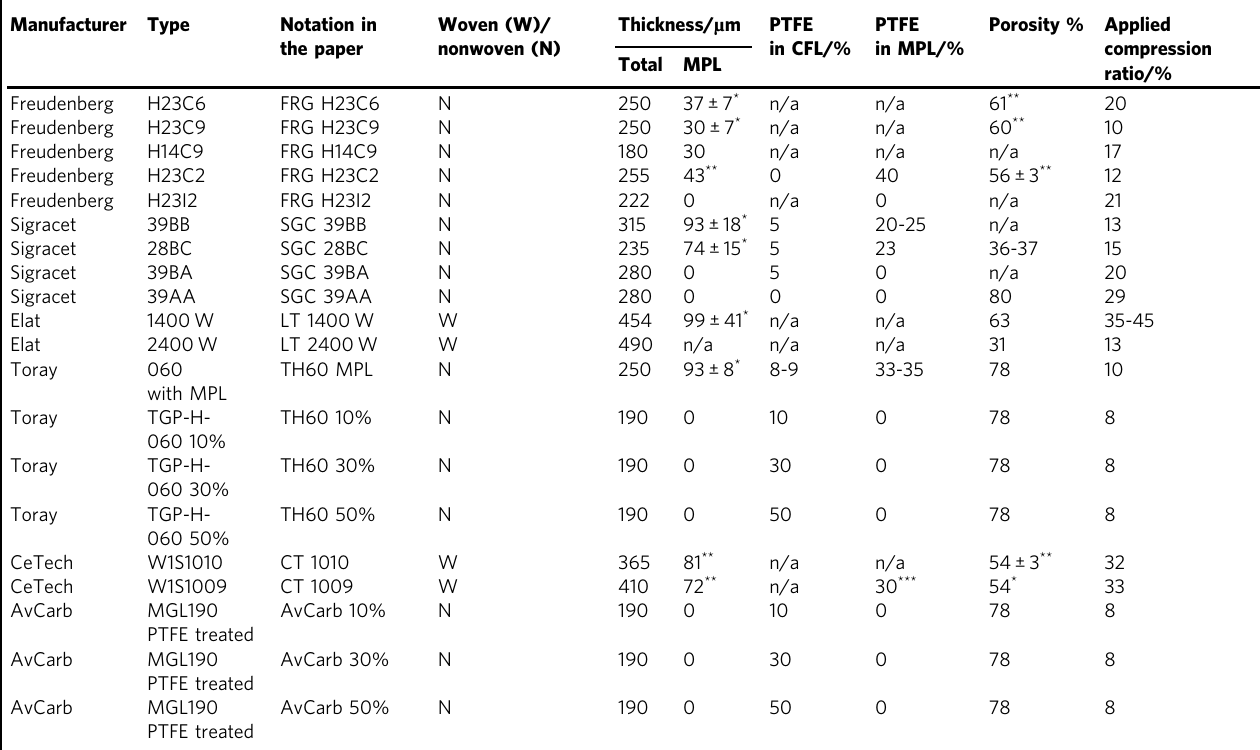
Table 1 The most important technical parameters and the used notation of the GDLs (*: own data, **: ref. 43 , ***: ref. 44 ). Manufacturer